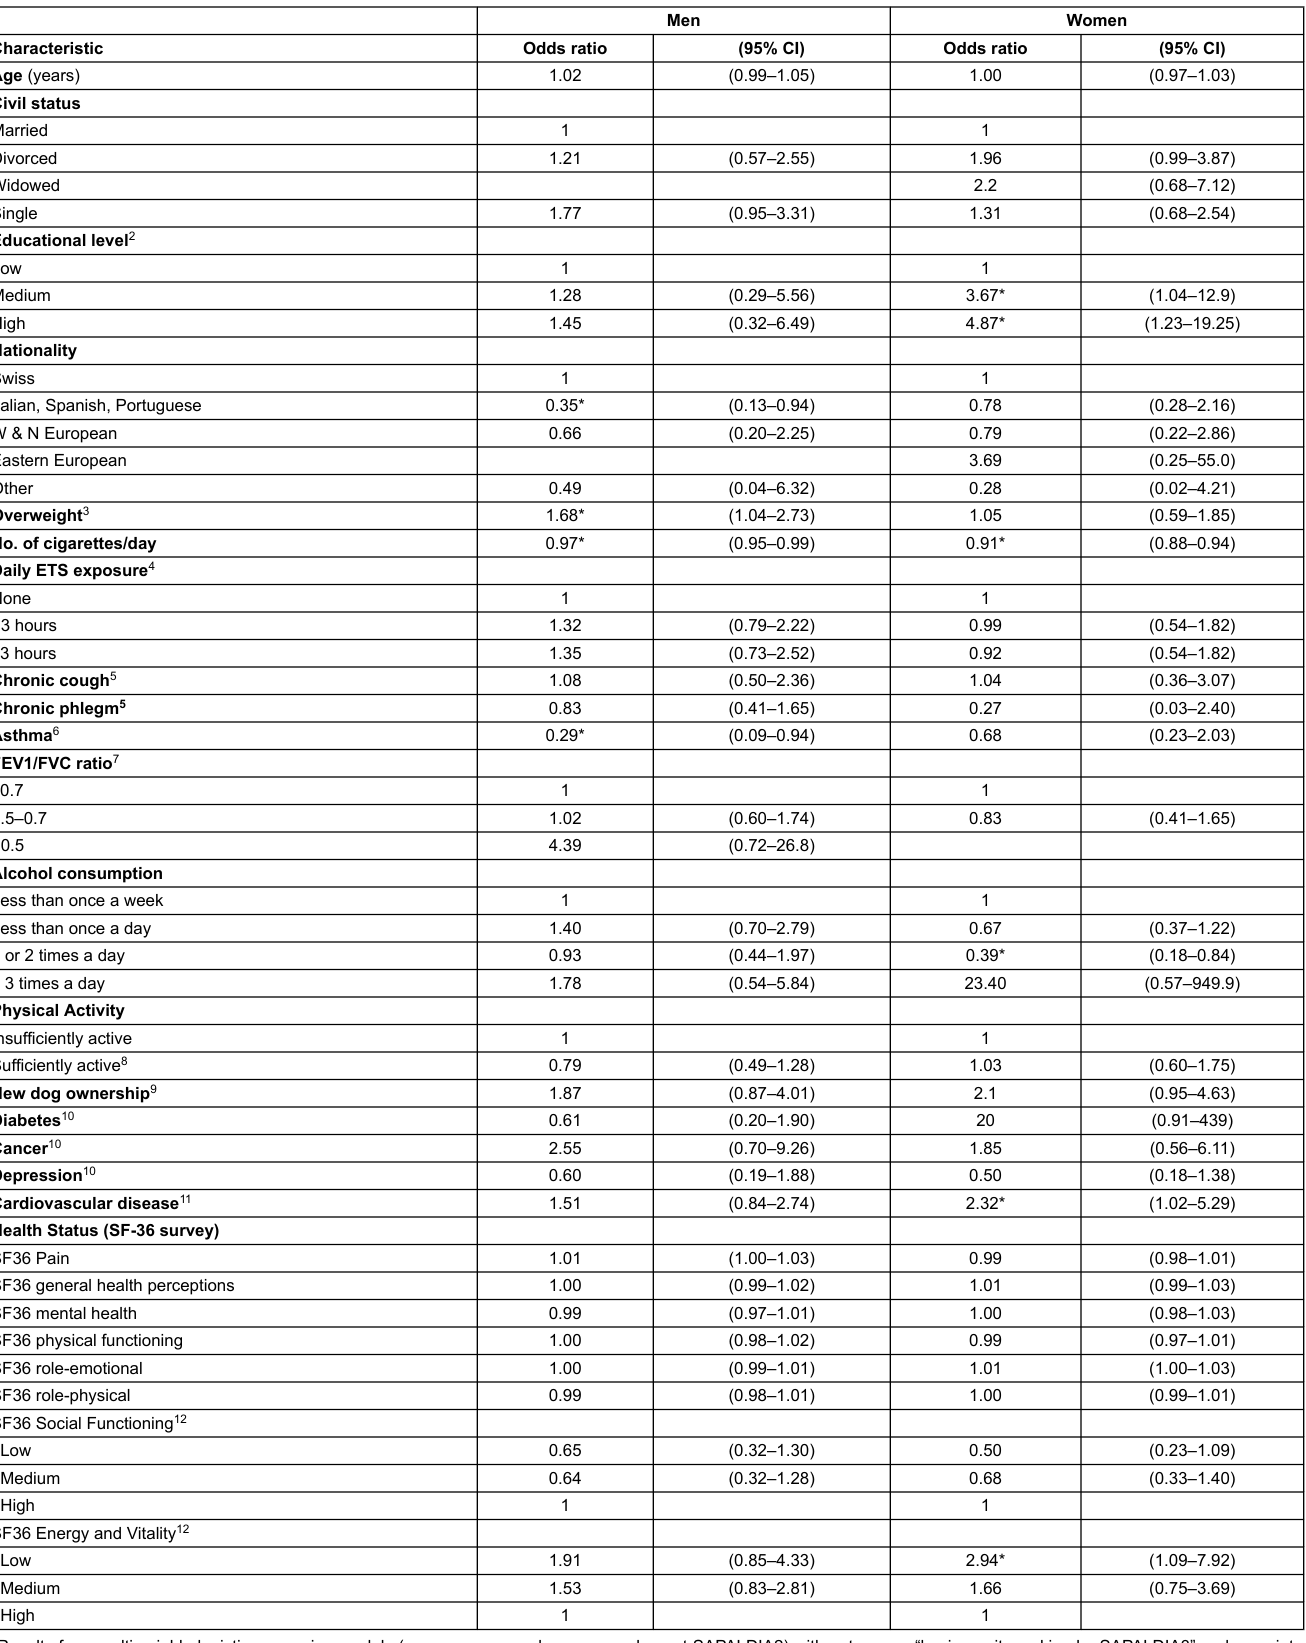
Table S7: Estimated independent associations of smoking cessation between SAPALDIA2 (2002) and SAPALDIA3 (2010/11) with different personal characteristics assessed at SAPALDIA2, by